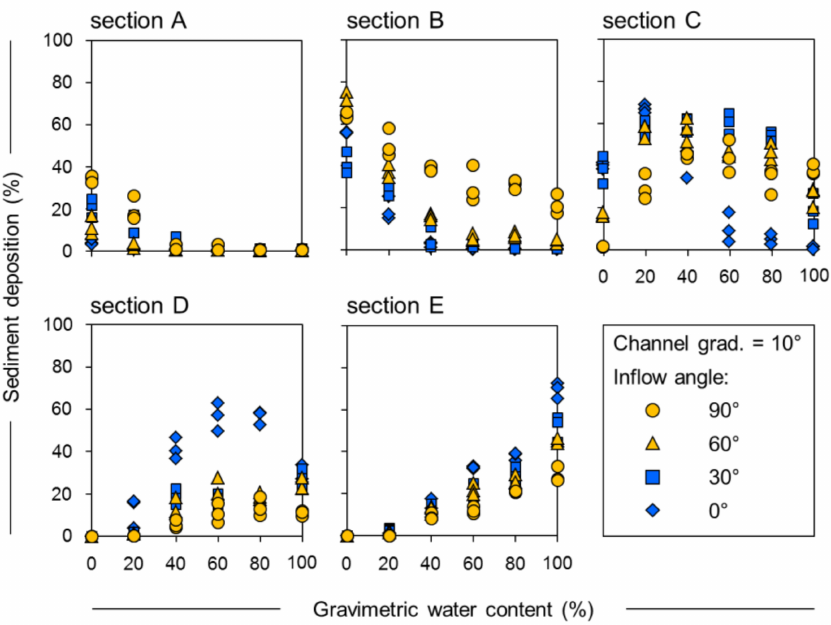
Figure 3. Sediment deposition in response to inflow angle modification for the 10 ◦ channel gradient, using sand and shale